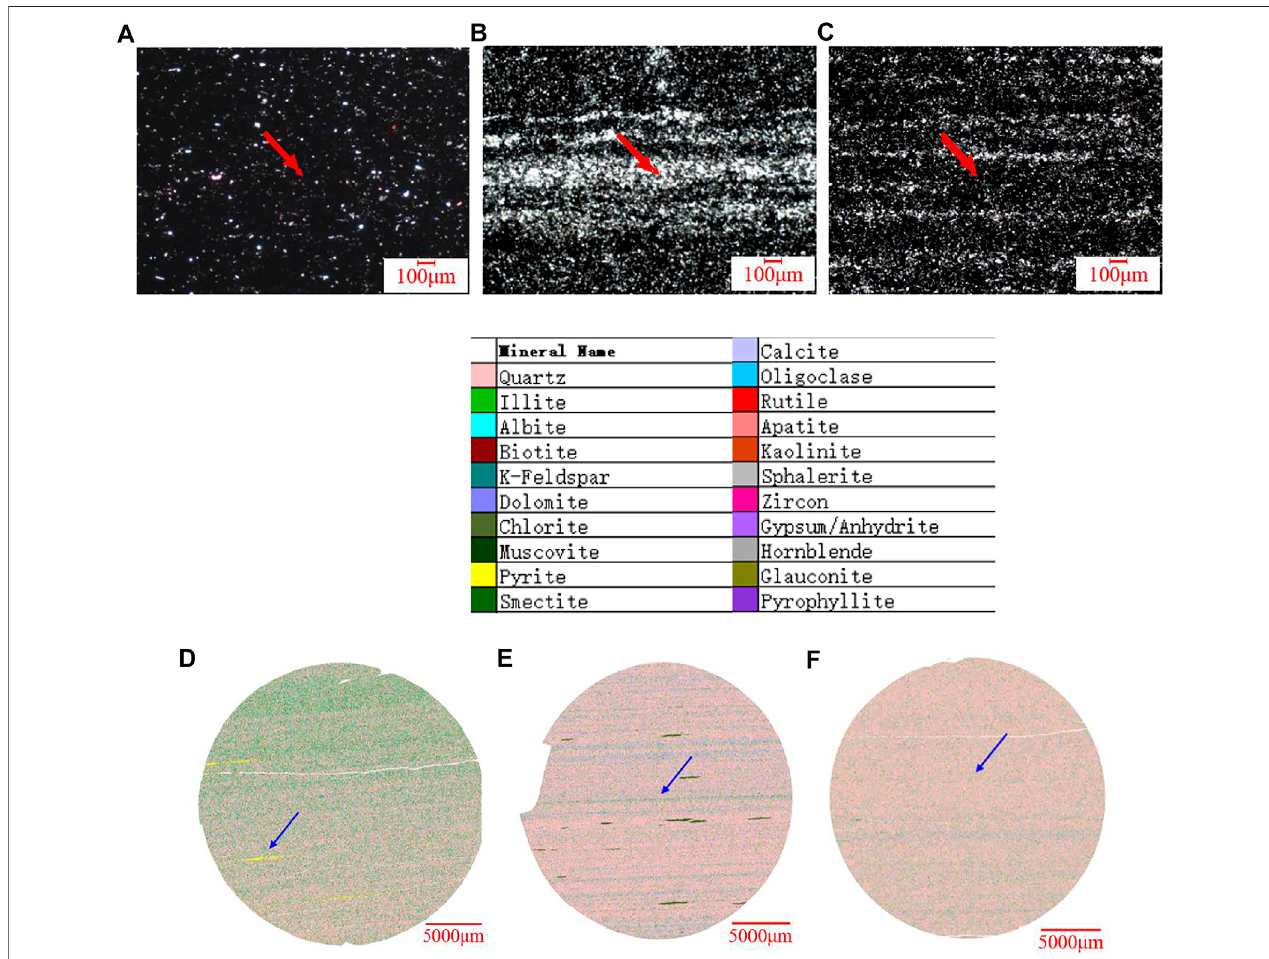
FIGURE 2 | Microlamination characteristics of shale: (A – C) thin sections of organic-rich lamination, silt lamination and clay lamination; (D – F) QEMSCAN images of pyrite lamination, clay lamination and silt lamination.